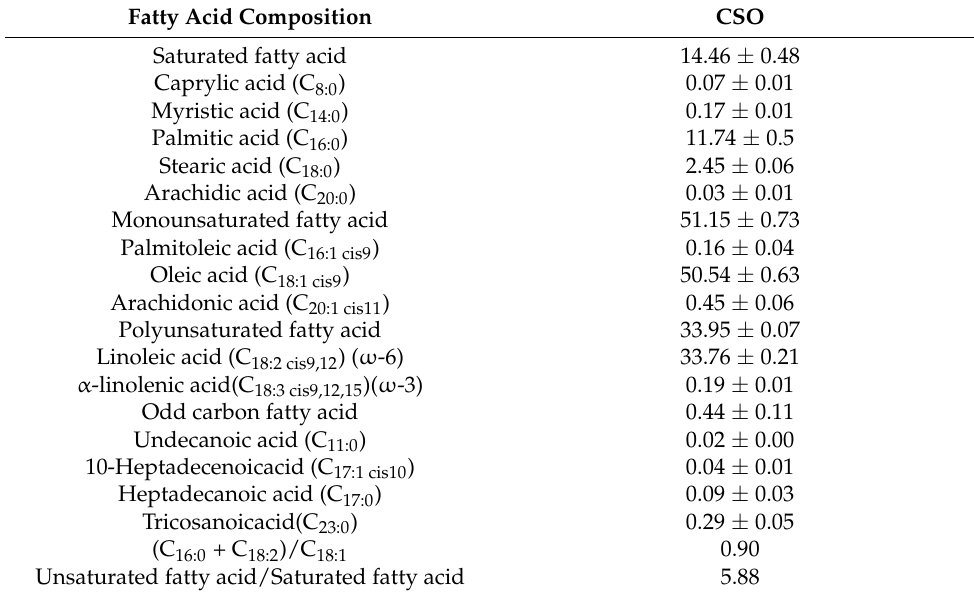
Table 1. Fatty acid composition (g/100 g) of CSO.